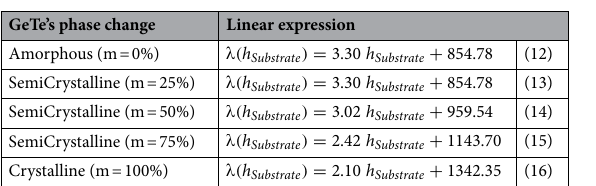
Figure 13. Absorption dependence of the silicon substrate thickness h Substrate in the range of 1100 to 1900 nm ( a ) amorphous; ( b ) semi-crystalline (m = 25%); ( c ) semi-crystalline (m = 50%); ( d ) semi-crystalline (m = 75%); ( e ) crystalline phases and ( f ) linear dependence of the peaks of ( a – e ) with the thickness of the substrate thickness ( h Substrate ).